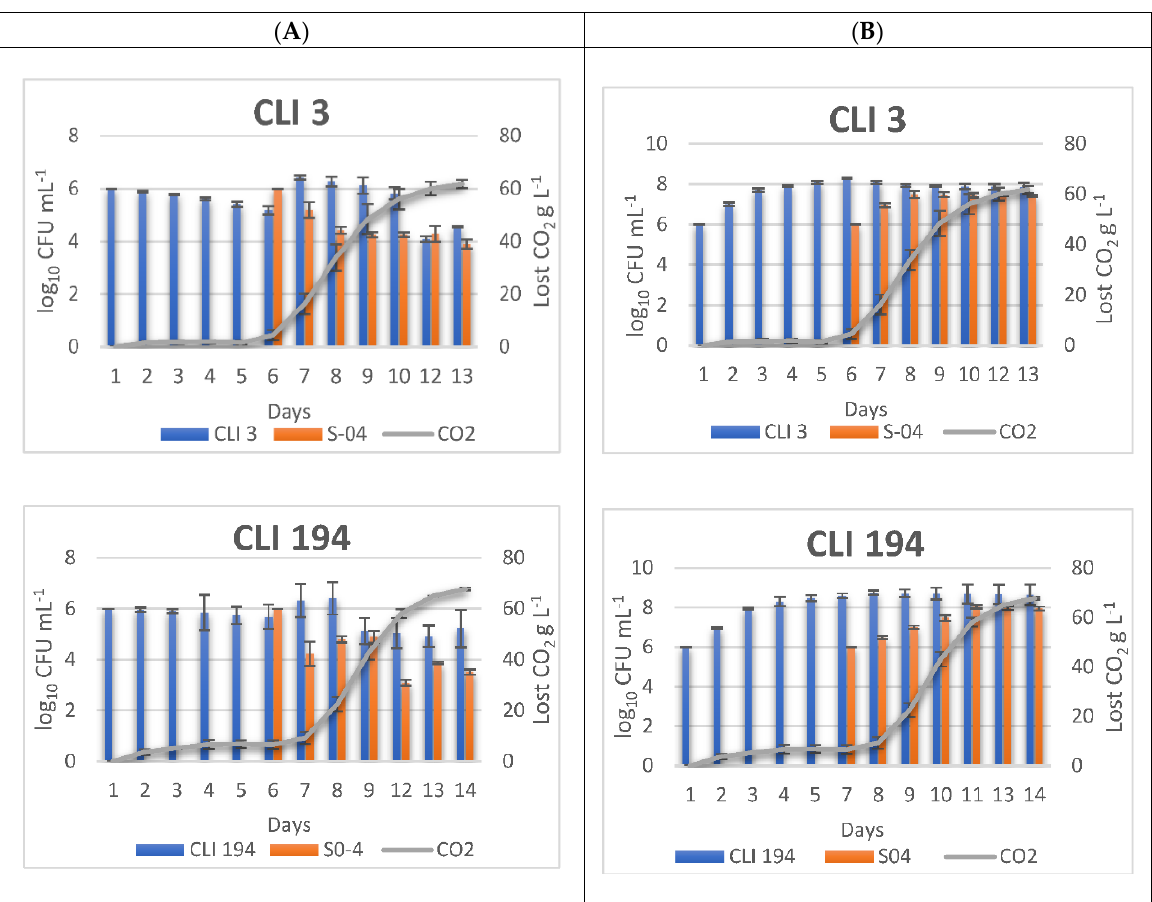
Figure 1. Fermentation kinetics in 1 L single fermentations for the eight studied strains. Each value is the mean of three trials ± standard deviations expressed in g CO 2 lost per day.